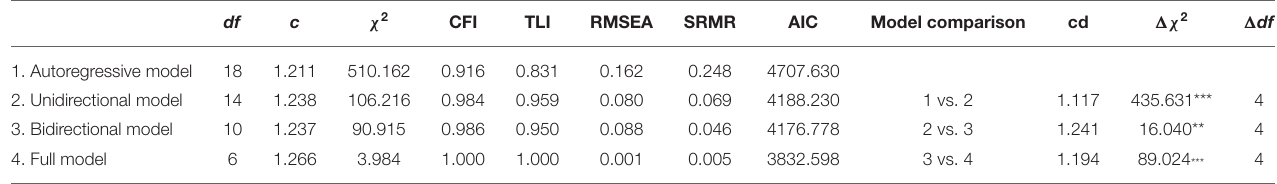
TABLE 5 | Model fit indices of parental control, depressive symptoms, and POGU. df c χ 2 CFI TLI RMSEA SRMR AIC Model comparison cd 1χ 2 1 df